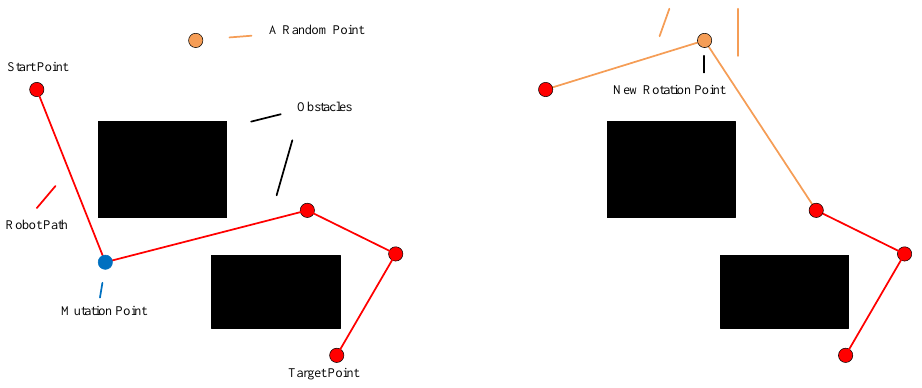
Figure 4. The mutation operator is presented. In the left sub-figure, a randomly selected rotation point (indicated by a blue circle) on the path is replaced by a free point (indicated by a yellow circle) randomly generated in the space. The resulting new path is shown in the right